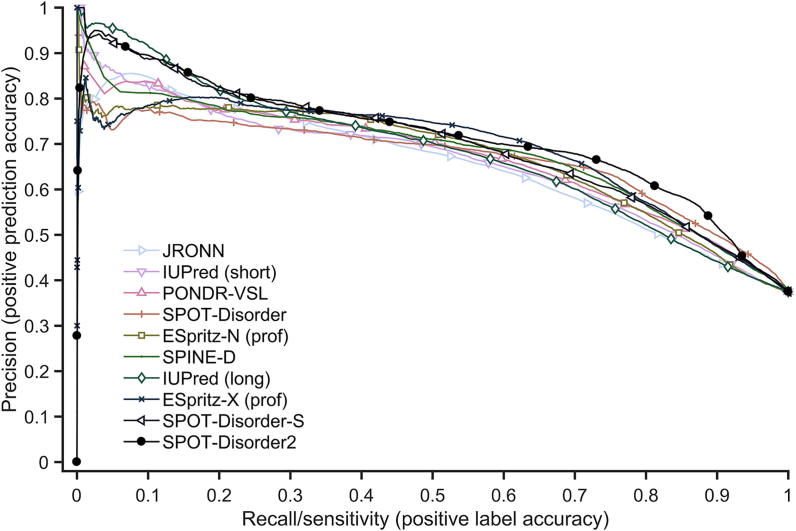
Precision–recall curves of the top 10 predictors for the DisProt228 datasetThe precision–recall curves were plotted by varying the threshold for defining disordered residues. ESpritz-N (prof) and ESpritz-X (prof) indicate profile-based ESpritz methods trained based on structural information obtained from PDB as determined by NMR or X-ray crystallography, respectively. SPOT-Disorder-S stands for SPOT-Disorder-Single.